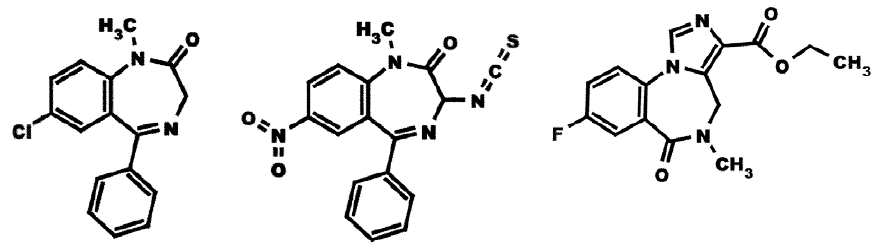
Figure 1. Chemical structures of diazepam, 3-NCS and Ro15–1788.